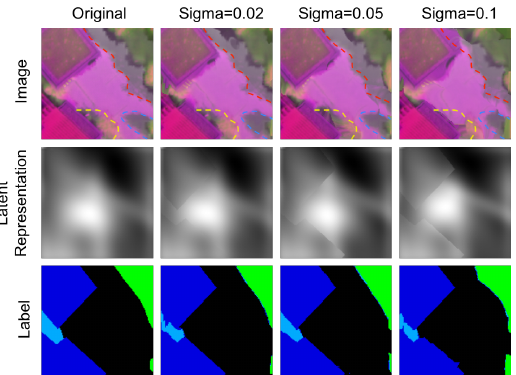
Figure 4. Generation of new samples given an input image and a GMM modifier standard deviation. One can observe buildings in dark blue, impervious surfaces in black and vegetation in green. While buildings geometry is preserved, one can notice stronger deformations with higher GMM modifier standard deviations (sigma), highlighted by the yellow, blue and red dashed lines.